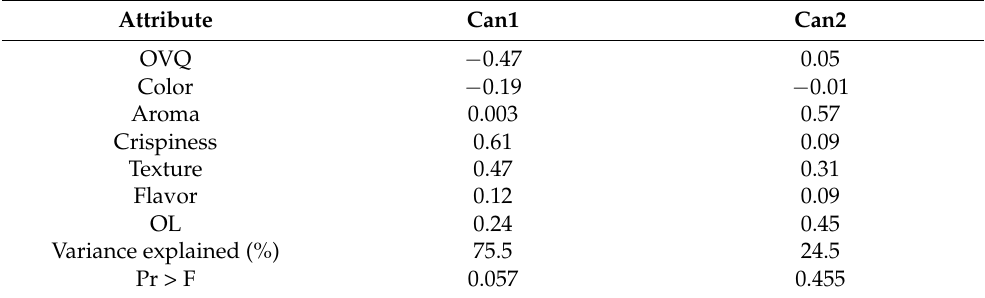
Table 3. Pooled within canonical correlation values 1 describing group differences among fried catfish